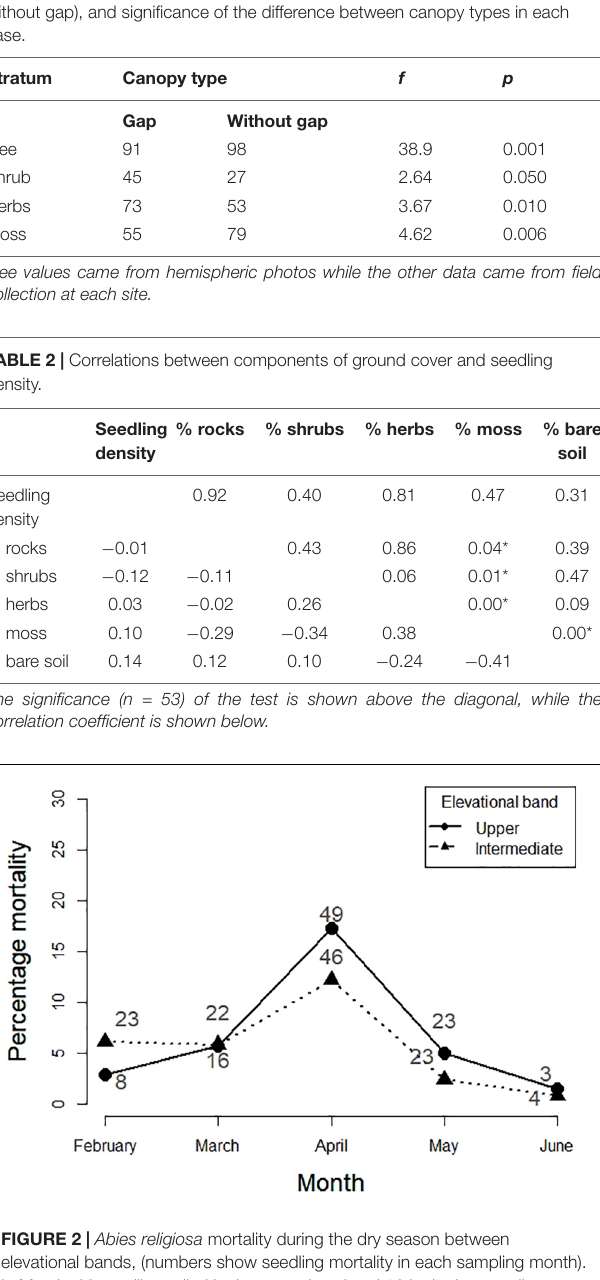
FIGURE 2 | Abies religiosa mortality during the dry season between elevational bands, (numbers show seedling mortality in each sampling month). In March, 22 seedlings died in the upper band and 16 in the intermediate one.